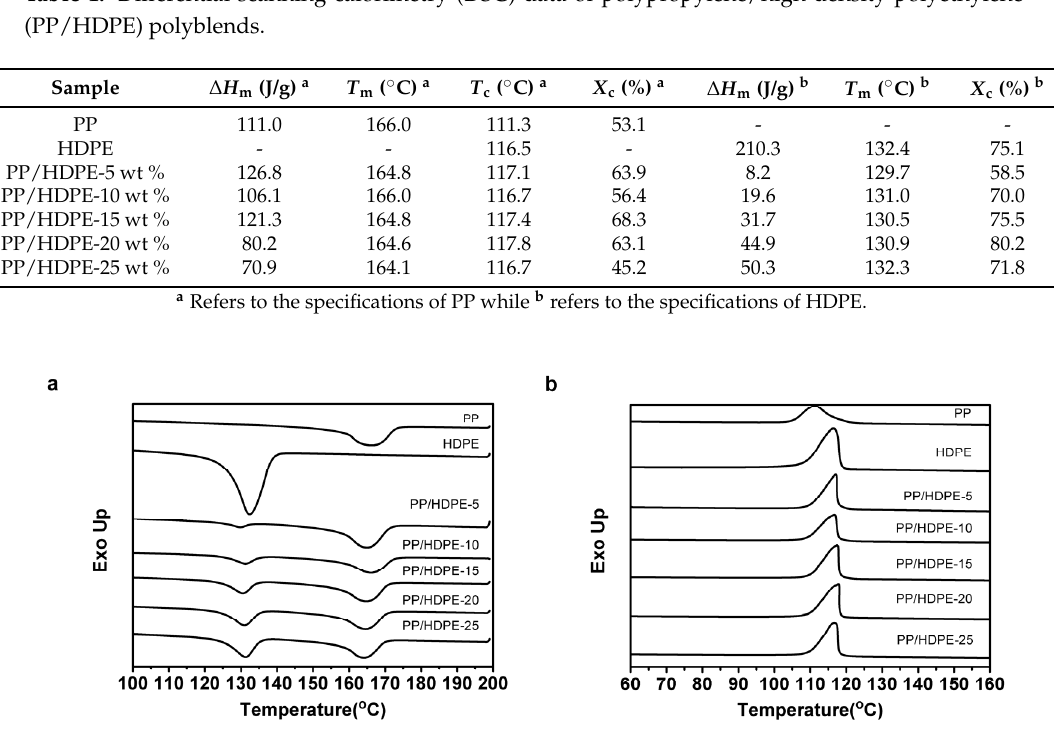
Figure 4. ( a ) Melting peak and ( b ) crystallization peak characterized in the differential scanning calorimetry (DSC) curve of PP/HDPE polyblends.